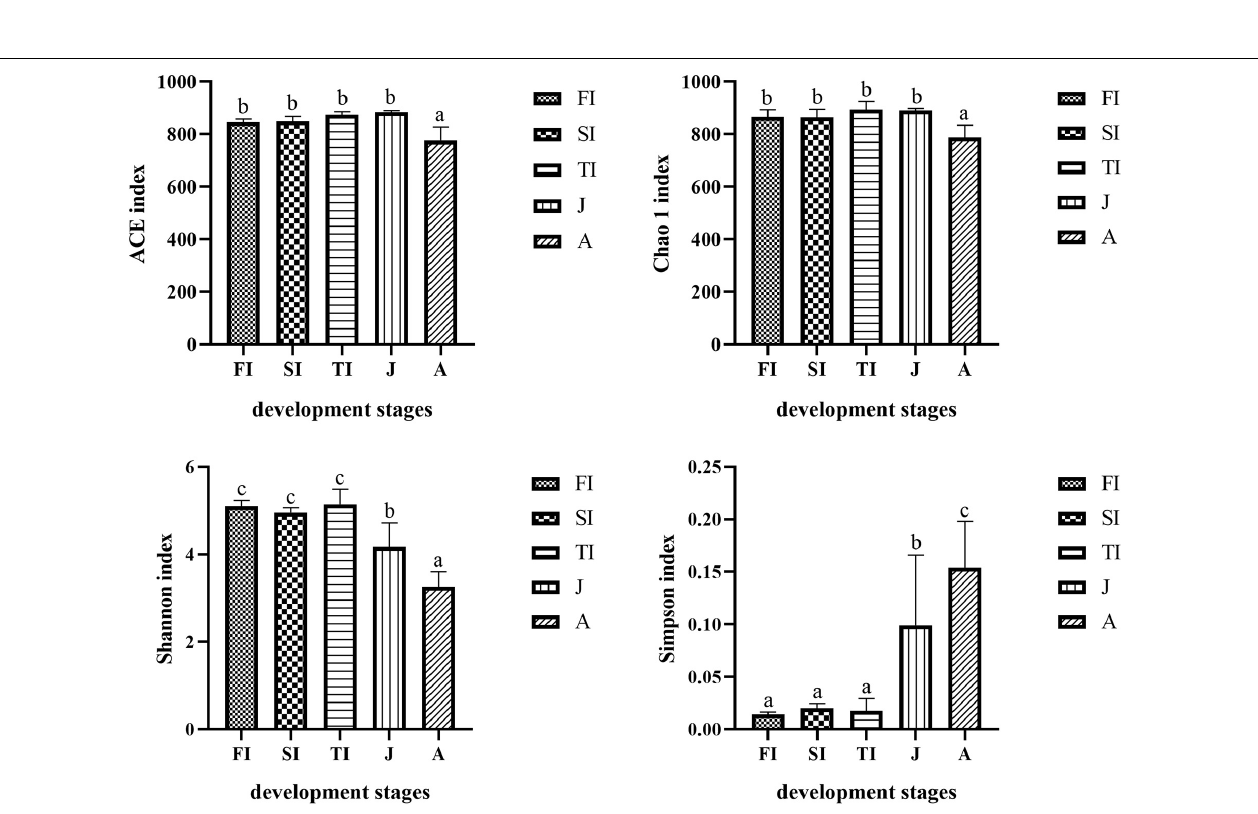
FIGURE 2 | Comparison and analysis of bacterial composition richness (Chao 1 index and ACE index) and diversity (Shannon index and Simpson index). The alpha diversity values were compared in the groups of different development stages. In every single histogram, column values with no letter or the same letters mean no significant difference between them ( P > 0.05), while with different small letters mean significant difference ( P > 0.05).